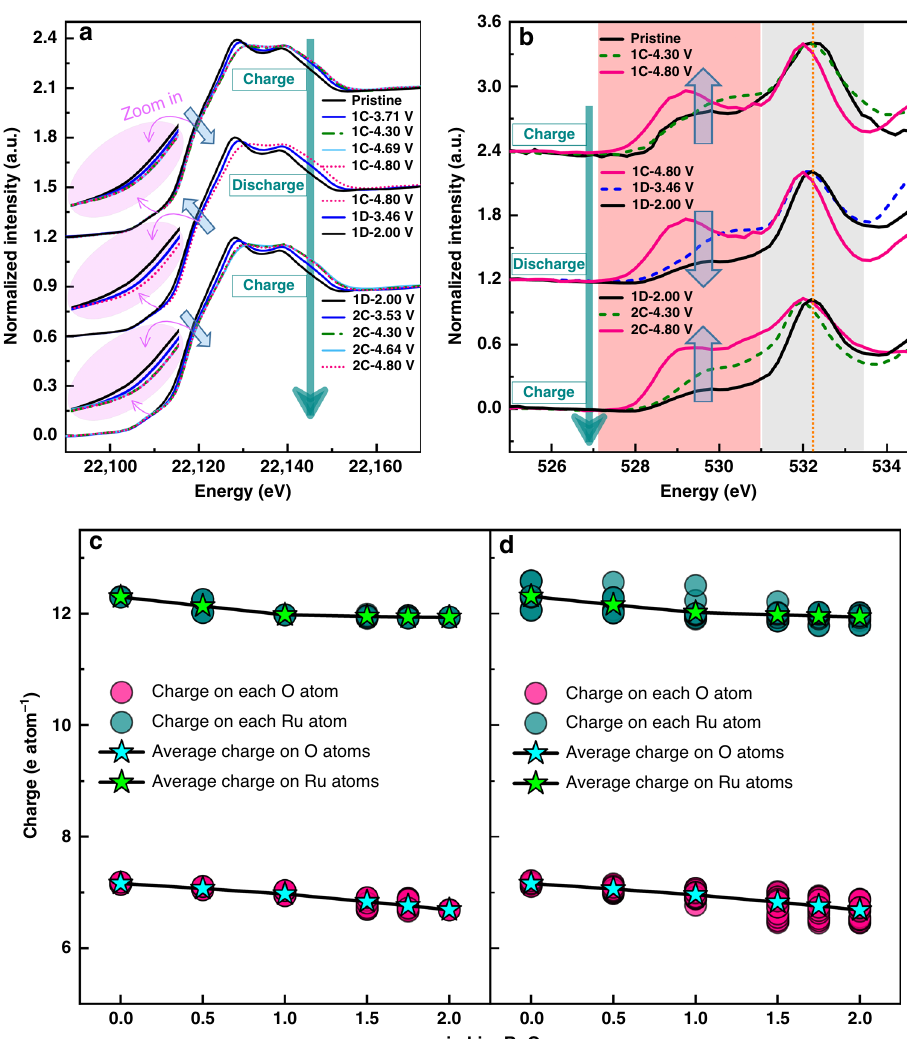
Fig. 5 Electronic structure changes. a , b Ex situ Ru K-edge ( a ) and O K-edge ( b ) XANES spectra of ID-Li 2 RuO 3 upon charging and discharging. 1 C, 1D and 2 C represent the fi rst charge, fi rst discharge and second charge, respectively. c , d Charge and average charge on Ru ions and O ions in R-Li 2 RuO 3 ( c ) and ID-Li 2 RuO 3 ( d ) with respected to the Li